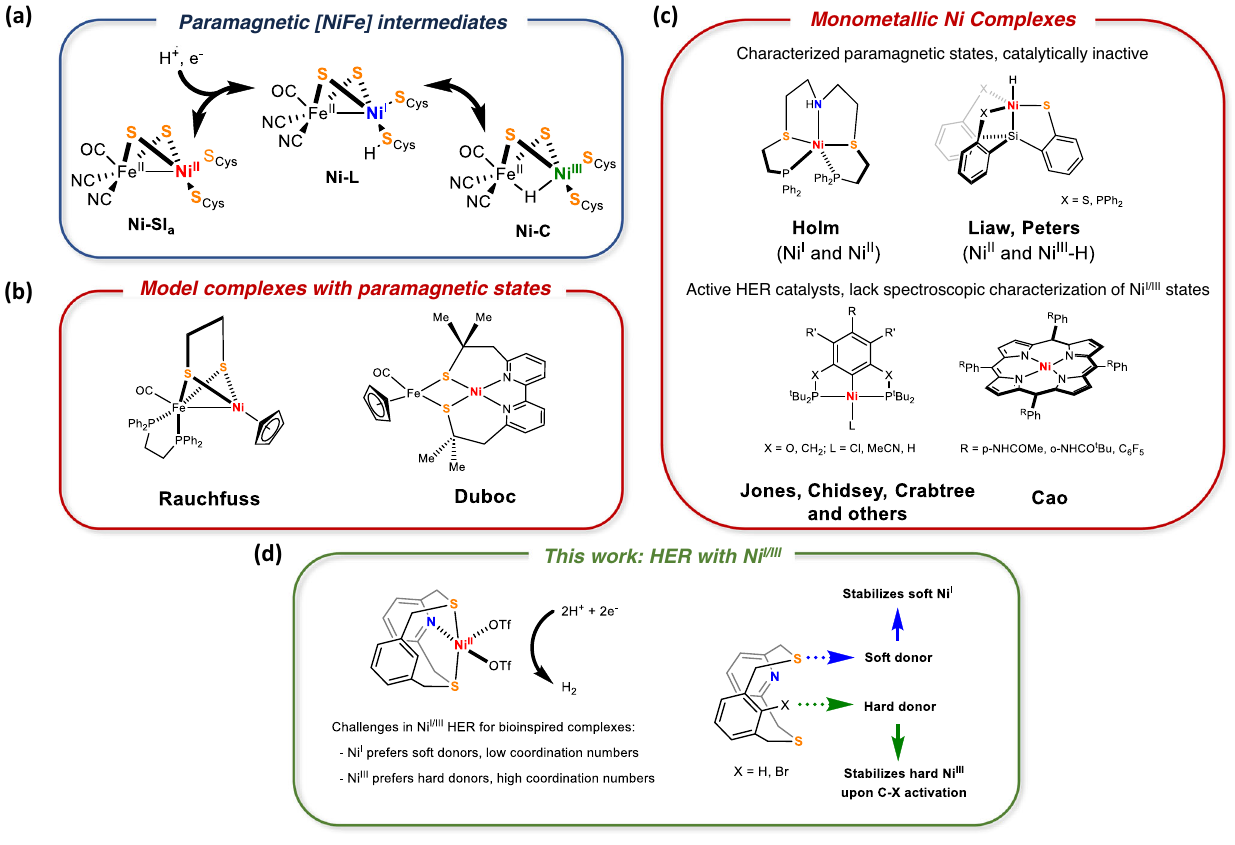
Fig. 1 | Hydrogen evolution reaction at paramagnetic Ni. a Paramagnetic intermediates involved in hydrogen redox catalyzed by [NiFe] hydrogenase. b Structuralmimicsof[NiFe]hydrogenasewithcharacterizedparamagneticstates and reported HER activity with strong acids. c Mononuclear Ni complexes with